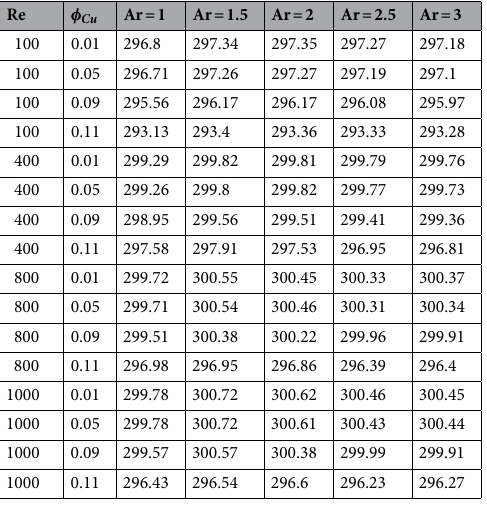
Table 3. Minimum temperature T min at the middle of the cavity for all parameters used to develop the